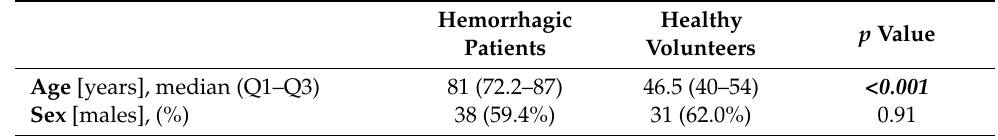
Table 1. Clinical characteristics of the patients and volunteers included in the